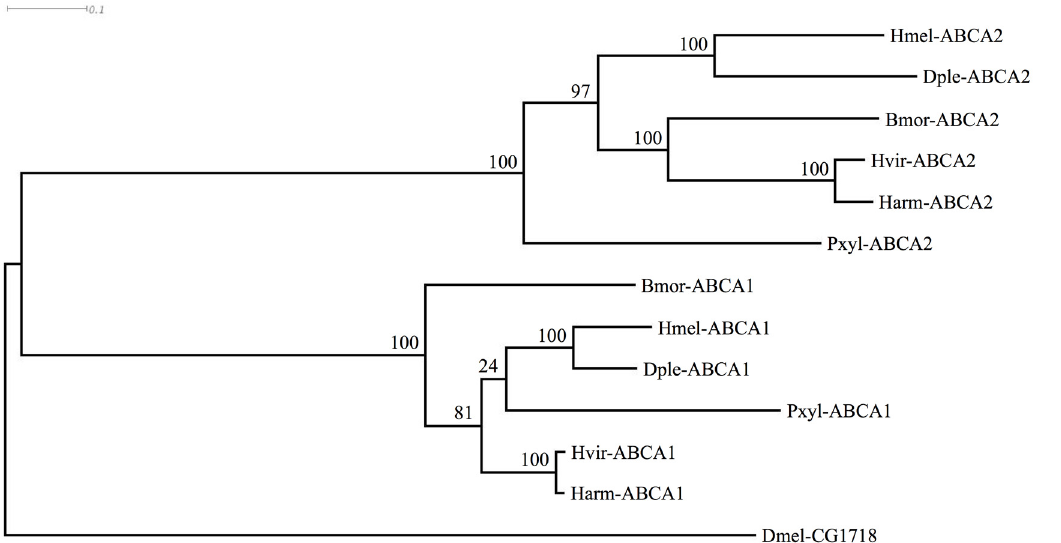
Fig 6. Phylogenetic tree showing clustering of ABCA1 and ABCA2 proteins of various Lepidoptera, with Drosophila homolog. Species abbreviations are: Bmor, Bombyx mori ; Harm, Helicoverpa armigera ; Hvir, Heliothis virescens ; Pxyl, Plutella xylostella ; Dple, Danaus plexippus ; Hmel, Heliconius melpomene ; Dmel, Drosophila melanogaster . The tree is based on the alignment shown in S1 Fig